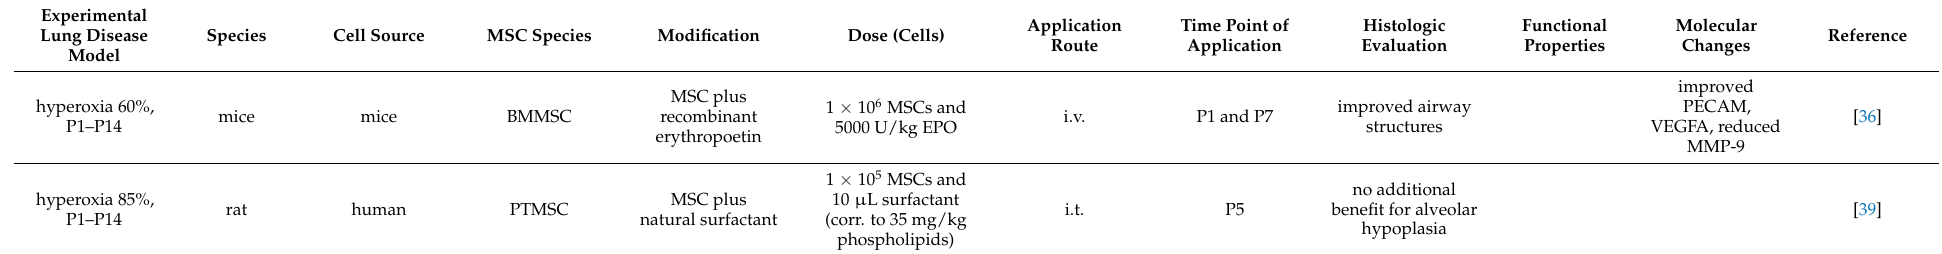
Table 6. Evaluation of additional benefits of MSC application in combination with further treatment approaches in the BPD rodent model.